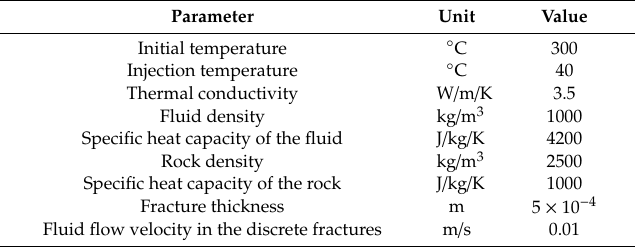
Table 2. Material parameters in the thermal consolidation problem.